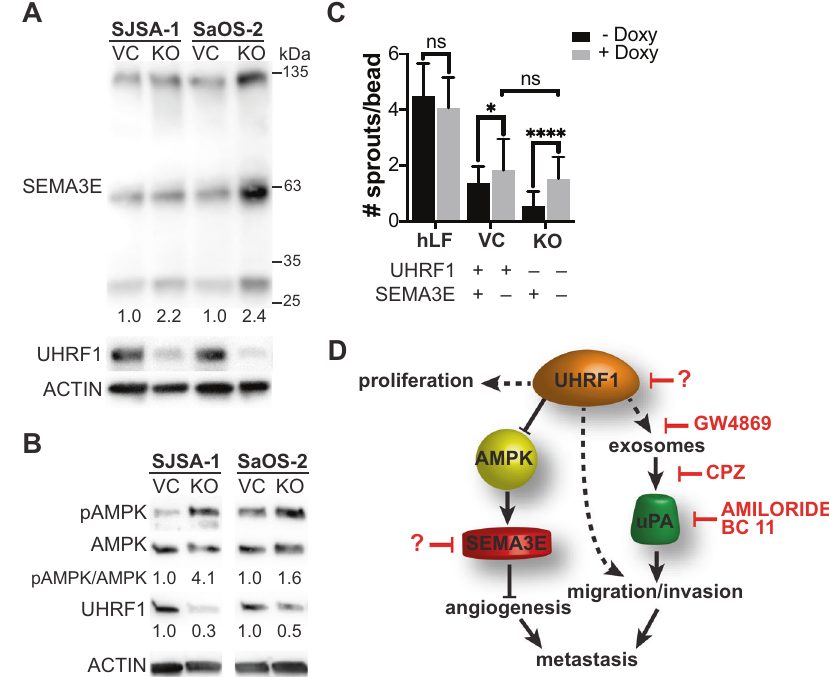
Fig. 5 UHRF1 decreases SEMA3E expression through suppression of AMPK activation to induce angiogenesis. A , B Western blot analysis of ( A ) SEMA3E in SJSA-1 and SaOS-2 VC and KO osteosarcoma cell lines quanti fi cation of KO normalized to VC; and ( B ) activated AMPK (pAMPK) and total AMPK with the quanti fi cation of the ratio. UHRF1 used to con fi rm VC and KO status. β -actin was used as a loading control. C Early phase sprouting angiogenesis (day 3) using human lung fi broblasts as assay control and SJSA-1 VC and KO cells with inducible sgRNA to knockout SEMA3E upon doxycycline addition in the fi brin gel bead assay. Quanti fi ed as the number of sprouts per bead. n = 30. ns not signi fi cant, * P < 0.05, **** P < 0.0001, by unpaired t test. D Model of UHRF1 oncogenic function in osteosarcoma. UHRF1 overexpression stimulates proliferation, exosome and uPA production that stimulates migration, invasion, and metastasis. UHRF1 also suppresses AMPK activation to inhibit SEMA3E and induce angiogenesis. Downstream of UHRF1, inhibitors of exosome secretion (e.g., GW4869), exosome endocytosis (CPZ), or uPA inhibitors (e.g., amiloride, BC11 hydrobromide) are attractive therapeutic options to decrease migration and metastasis. The development of UHRF1-targeted therapeutics might result in a bene fi cial decrease in both tumor growth and pulmonary